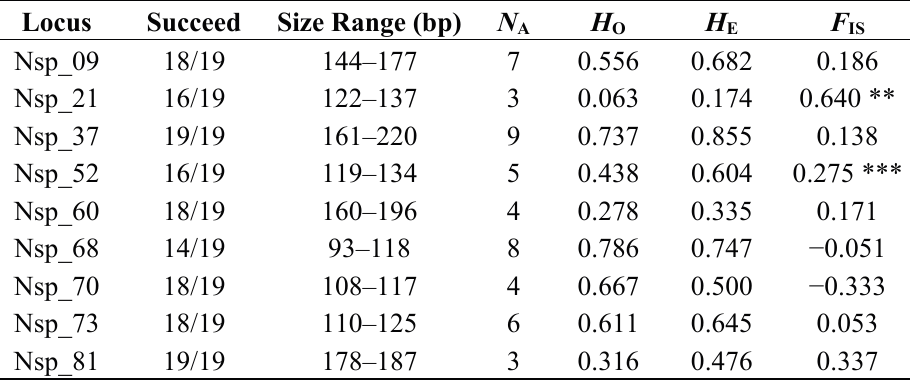
), observed ( H ) and expected ( H ) heterozygosities, A O E ). IS H H F A O E IS